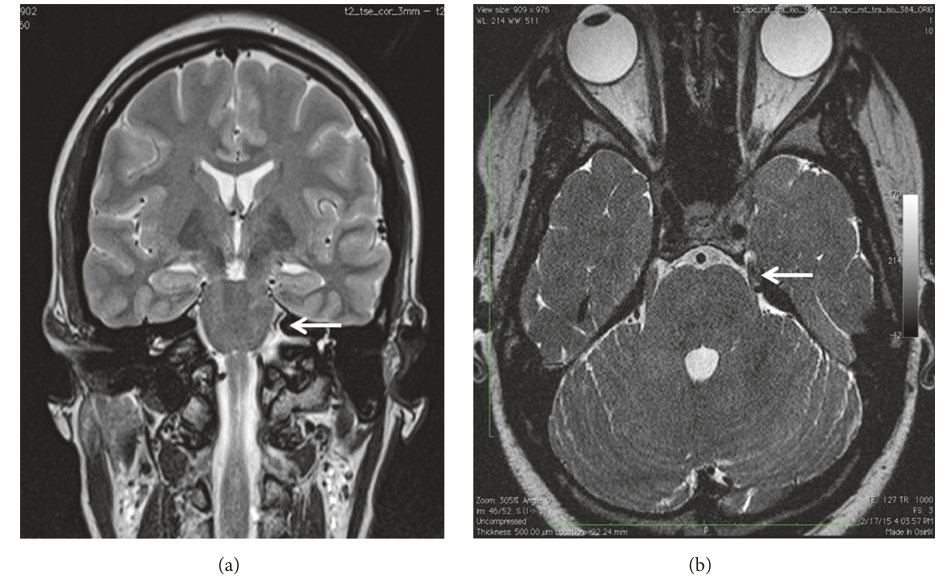
Figure 2: (a) “Coronal view” and (b) “axial view” of the brain showing impingement of cerebellar vein onto the left trigeminal nerve.